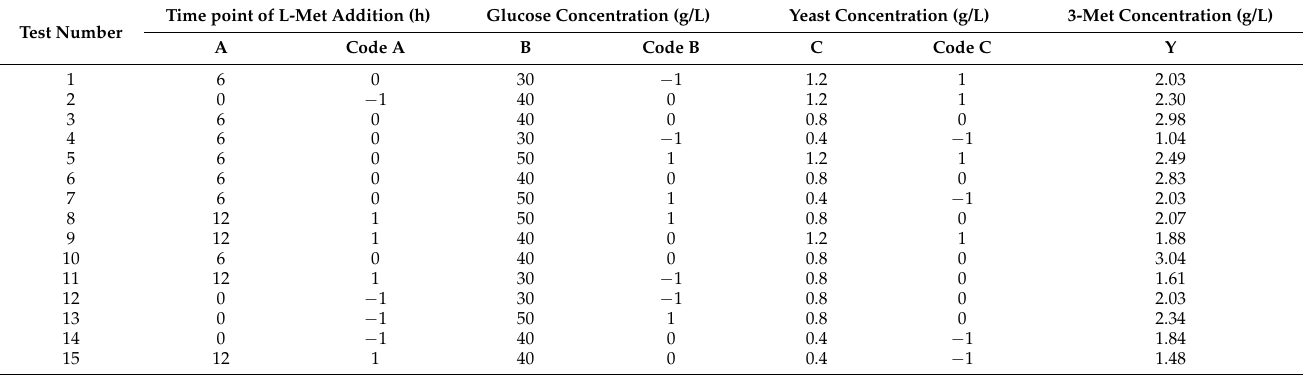
Table 4. The BBD design and the responses of the dependent